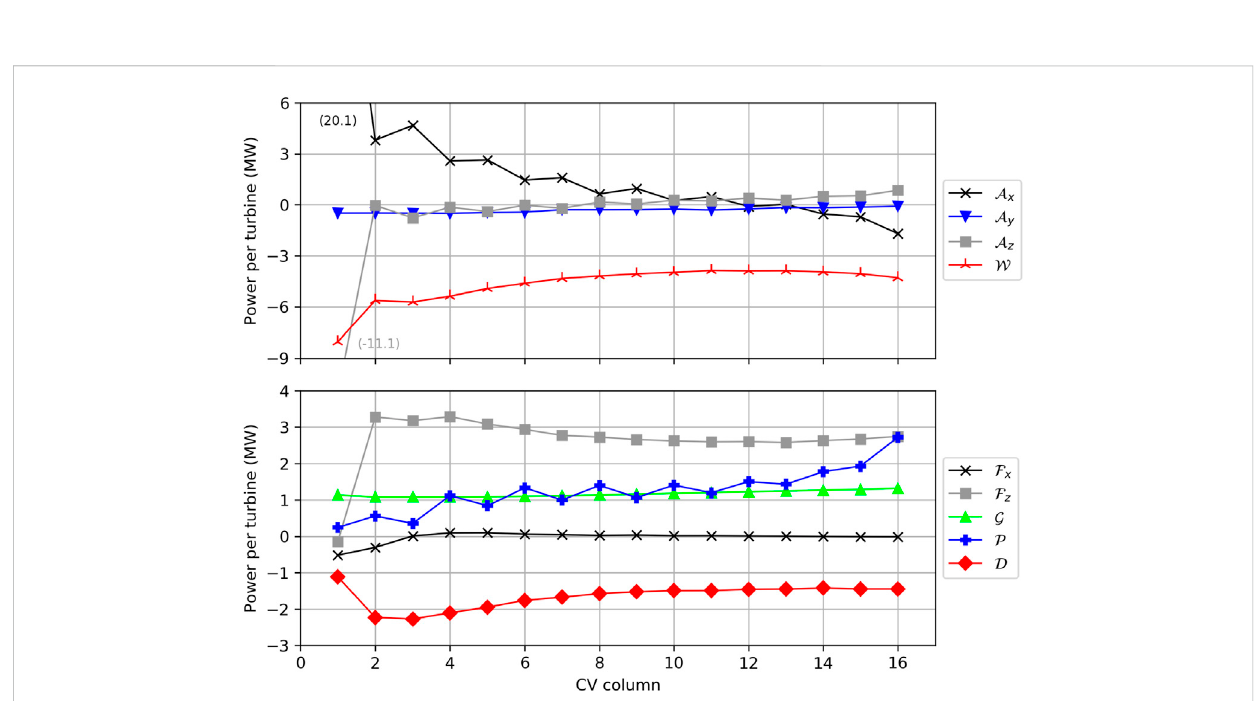
FIGURE 9 Energybudgetsinsidethewindturbinecontrolvolumes Ω wt ,averagedalong y .Thebudgettermsare:advectionofKEthroughleft/right ( A x ) ,south/ north ( A y ) andbottom/top ( A z ) boundaries,energyextractionbywindturbines ( W ) ,turbulent fl uxesthroughbottom/topboundaries ( F z ) ,geostrophic forcing ( G ) , perturbation pressure gradients ( P ) and dissipation ( D ) . The buoyancy term ( B ) and the horizontal turbulent fl uxes ( F x and F y ) are not shown, because they are very small (see Figure